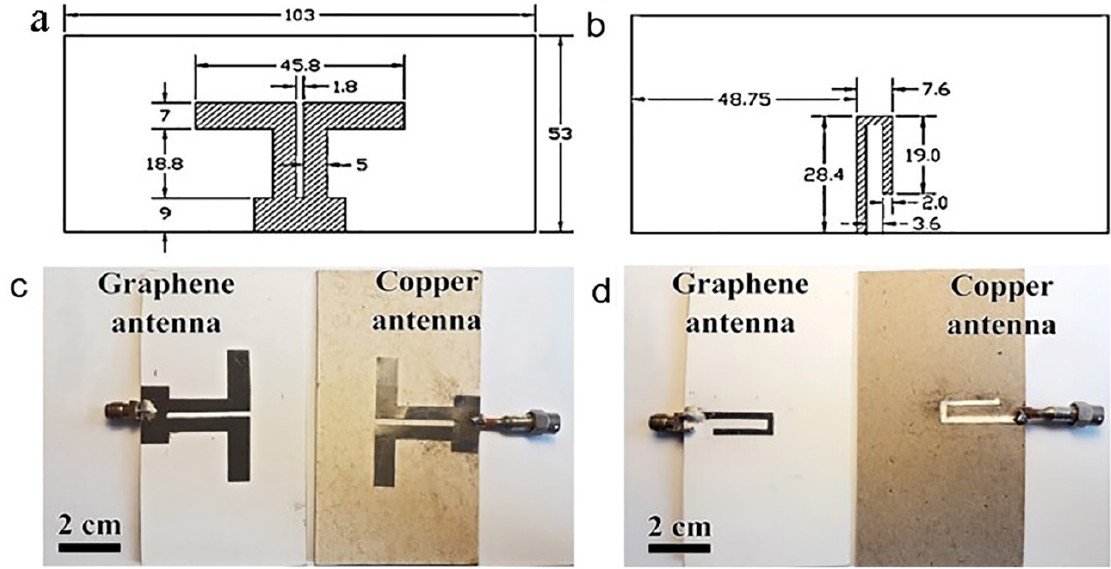
Figure 1. ( a , b ) Design of the front and reverse sides of antennas. The sizes are given in mm. ( c , d ) The photos of the front sides and the reverse (J-shaped power conductor) sides of ACu and AGr antennas.